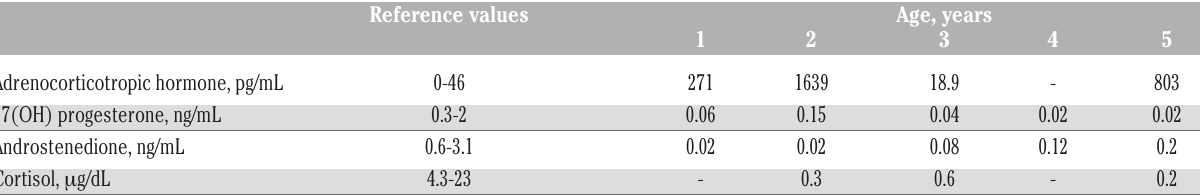
Table 1. Patient’s hormonal profile throughout the first 5 years of follow-up.